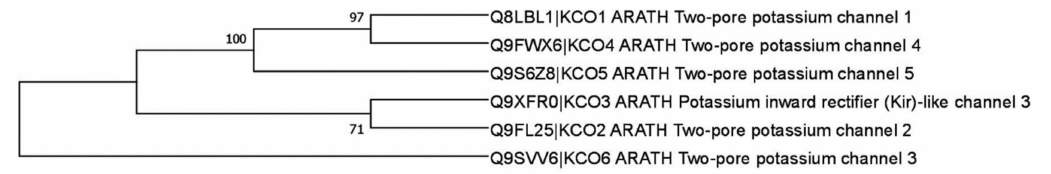
Figure 2. Phylogenetic tree of the TPK and KCO proteins of Arabidopsis thaliana . Full-length proteins from Arabidopsis were used for phylogeny reconstruction with the maximum likelihood method and WAG substitution